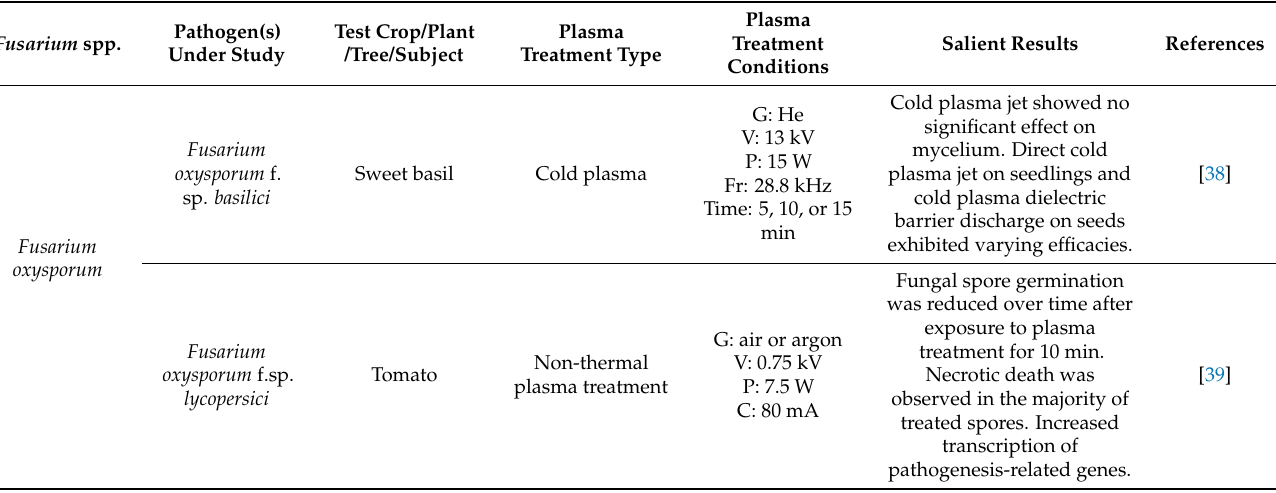
Table 1. Summary of the research on “Non-thermal plasma”/“cold plasma” against inactivation of Fusarium spp. spores or